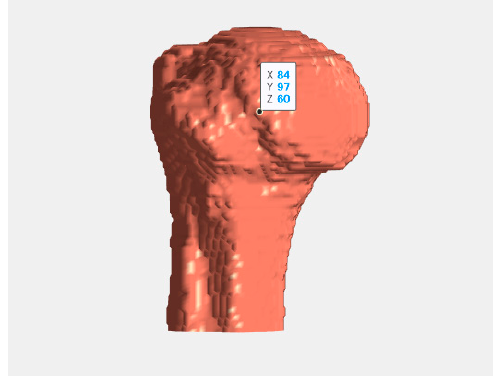
Figure 3. An example of the acquired coordinate value in the anatomical neck.